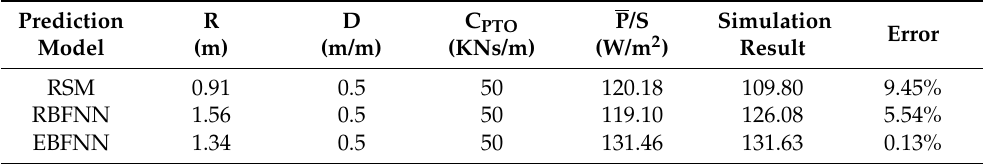
Table 3. Optimization